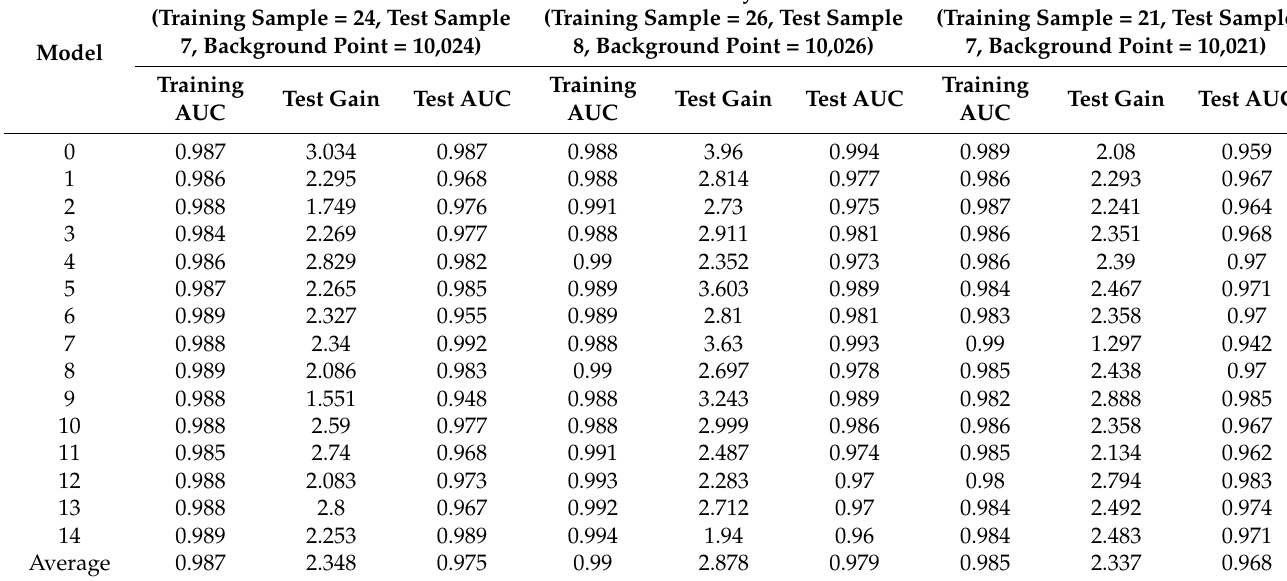
Table 2. MaxEnt special distribution model output for training area under curve (AUC), test gain, and test AUC for eastern sarus crane ( Antigone antigone sharpii ) in the Ayeyarwady Delta in the summer season, the rainy season, and the winter season in Ayeyarwady Delta, the Union of Myanmar.